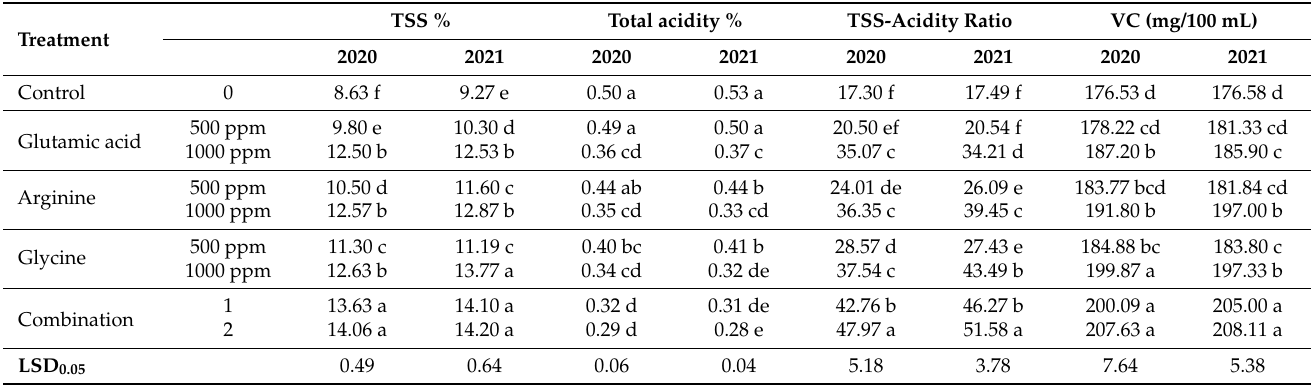
Table 5. The influence of glutamic acid, arginine, and glycine amino acids on the fruit content from TSS, total acidity, TSS-acidity ratio, and VC of guava during the 2020 and 2021 seasons. TSS % Total acidity % TSS-Acidity Ratio VC (mg/100 mL) Treatment